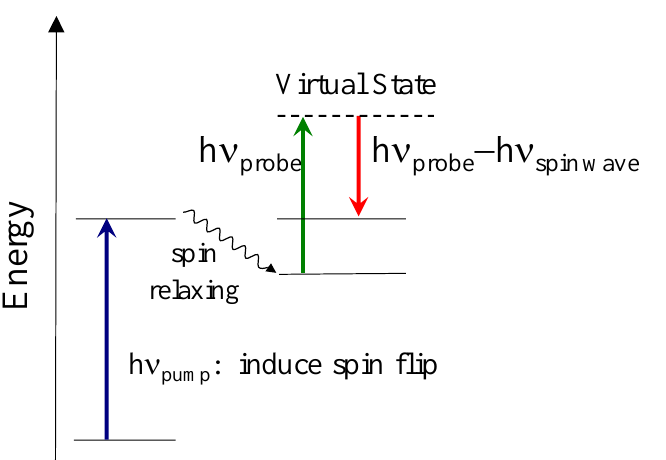
Figure 1. Schematic energy diagram of the processes of spin flip, spin relaxing, and spin wave scattering. In the figure, Stokes spin wave scattering is presented.